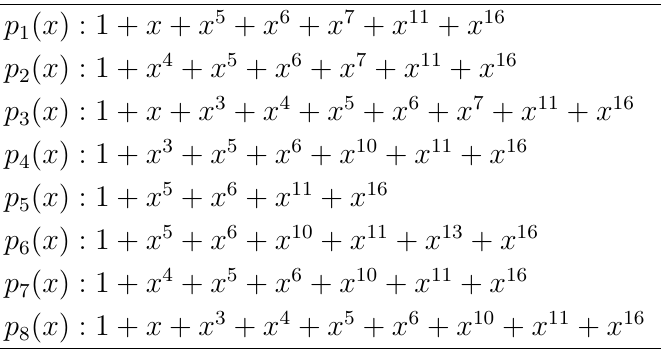
Table 1. Primitive feedback polynomials.